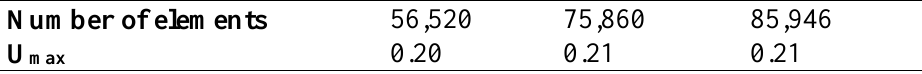
Table 2. Grid independence test for the 25 o roof pitch